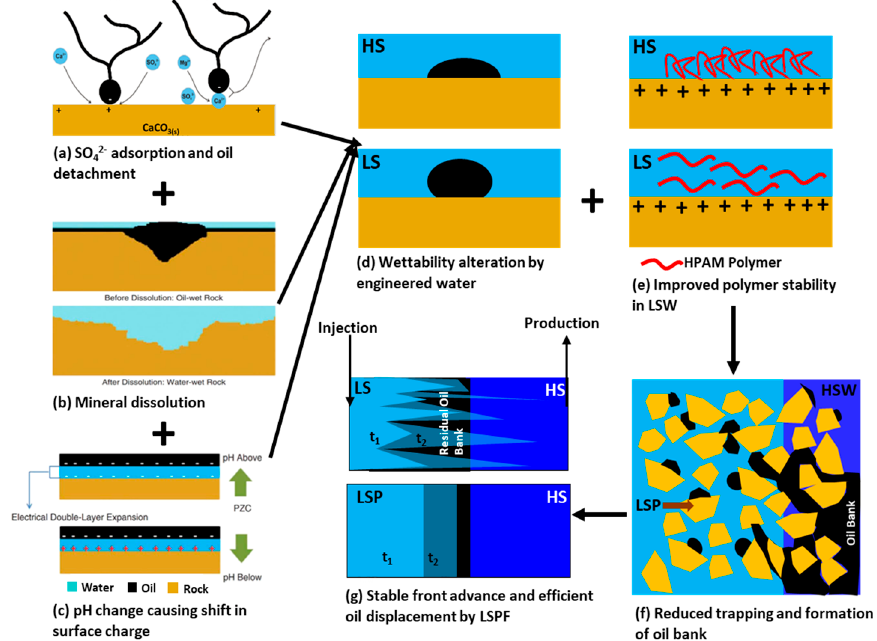
Figure 7. Illustration of governing mechanisms for incremental oil recovery using hybrid LSPF: ( a – d ) the functions of LSW [58,169] ( e ) the polymer stability in LSW; ( f ) the formation of the oil bank [170]; ( g ) the final outcomes of the process, i.e., detachment, mobilization, and displacement of the residual oil bank by combined LSPF.